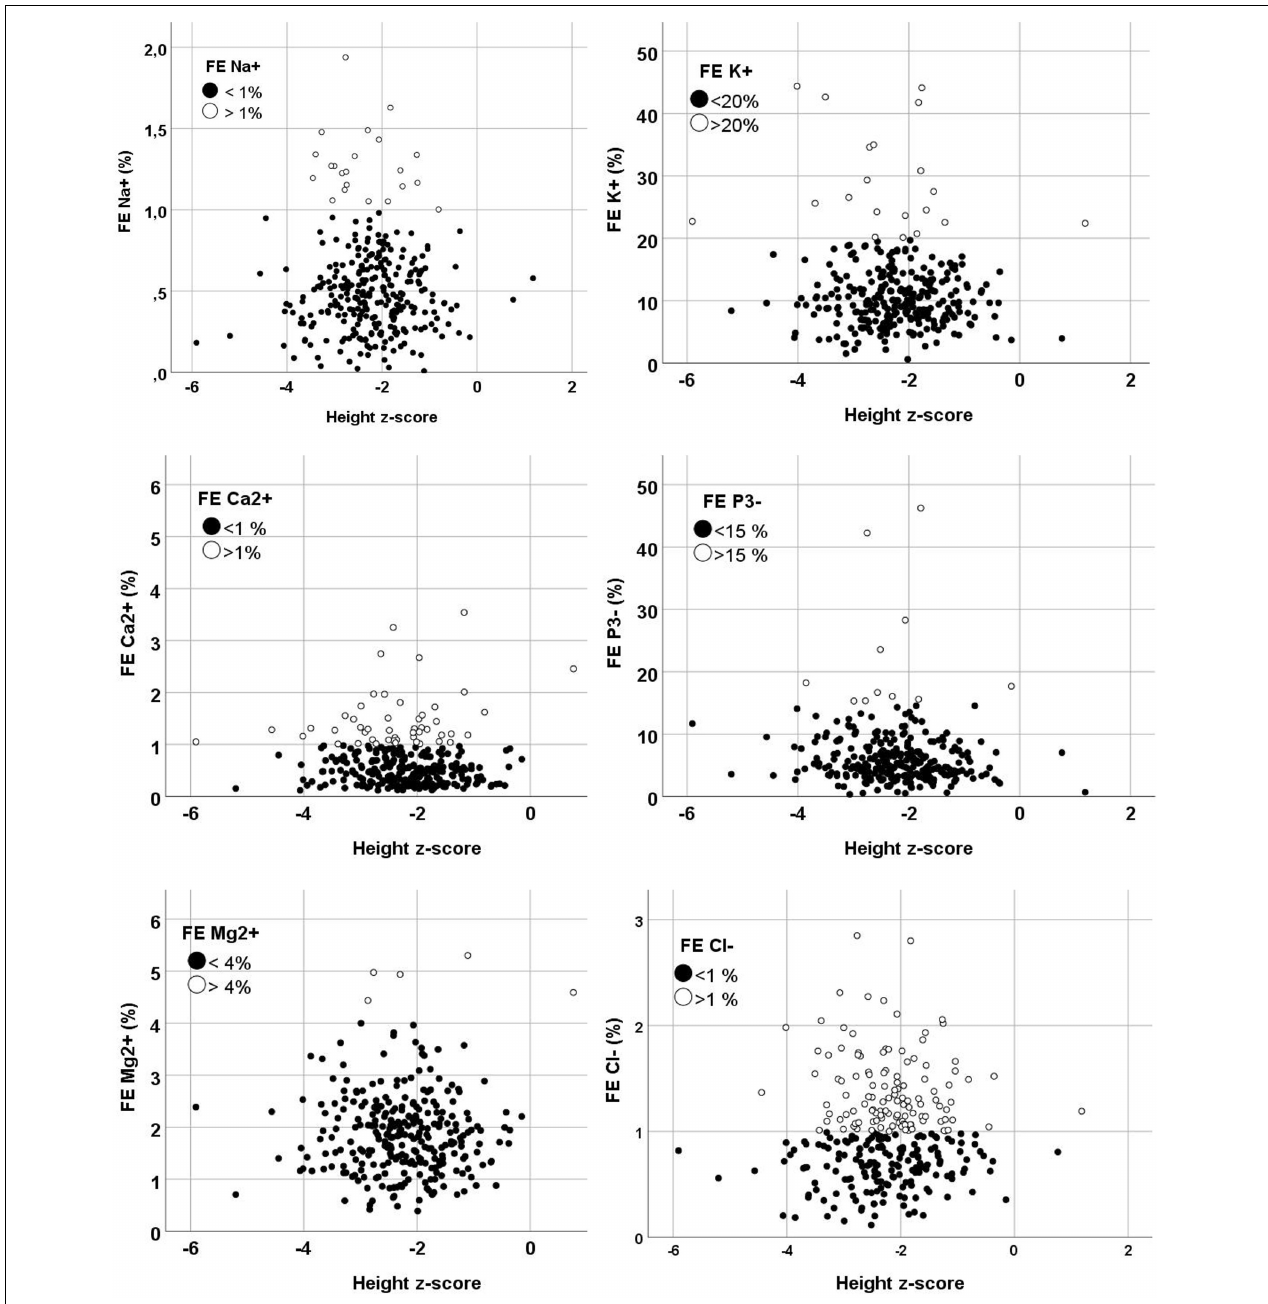
FIGURE 1 | Grouped scatters of the fractional excretion by height z-scores. Normal fractional excretion values are displayed in black dots and abnormal fractional excretion values are displayed in white dots. FE, fractional excretion.